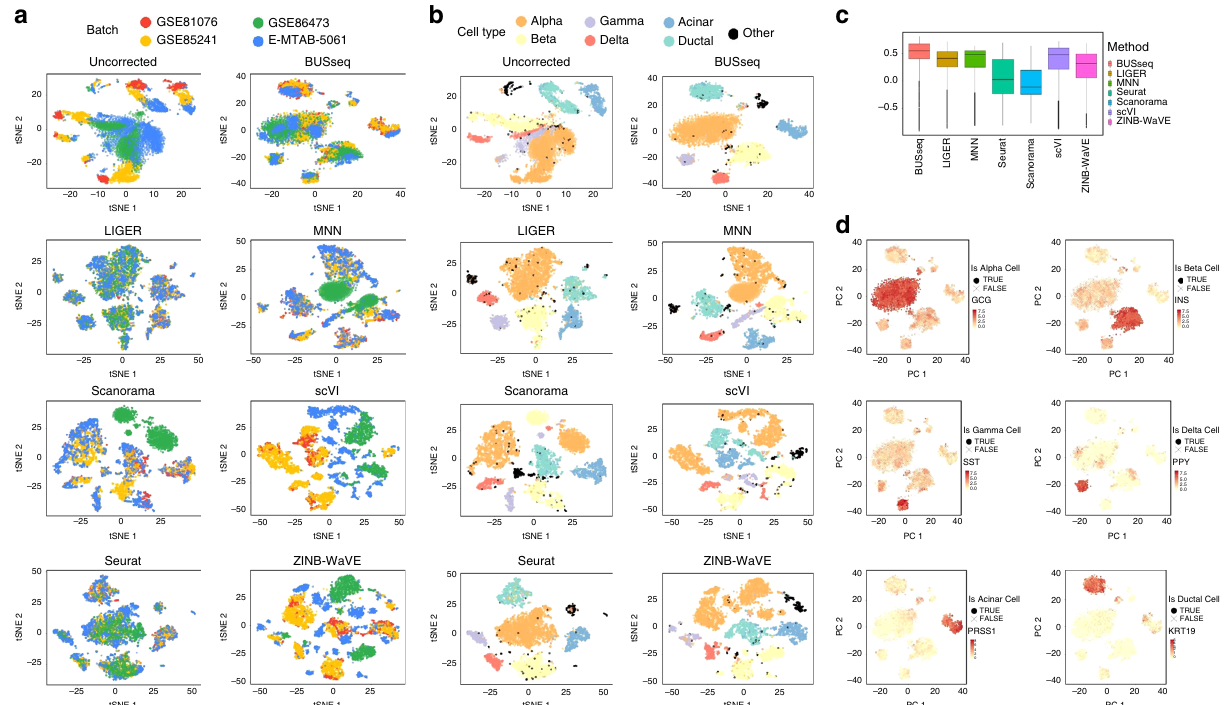
Fig. 7 t-SNE plots for the pancreas data. a t-SNE plots colored by batch. b t-SNE plot colored by FACS cell type labels. c The boxplot of silhouette coef fi cients for all of the compared methods. In the boxplot, the central line denotes the median; the upper and lower bounds represent the fi rst and third quartiles; and the whiskers extend to a maximum of 1.5 times the interquartile (IQR) beyond the box, where the IQR is the difference between the third and the fi rst quartiles. d The expression levels of six marker genes, GCG for alpha cells, INS for beta cells, SST for gamma cells, PPY for delta cells, PRSS1 for acinar cells, and KRT19 for ductal cells, shown in the t-SNE plot of the corrected count data of BUSseq,